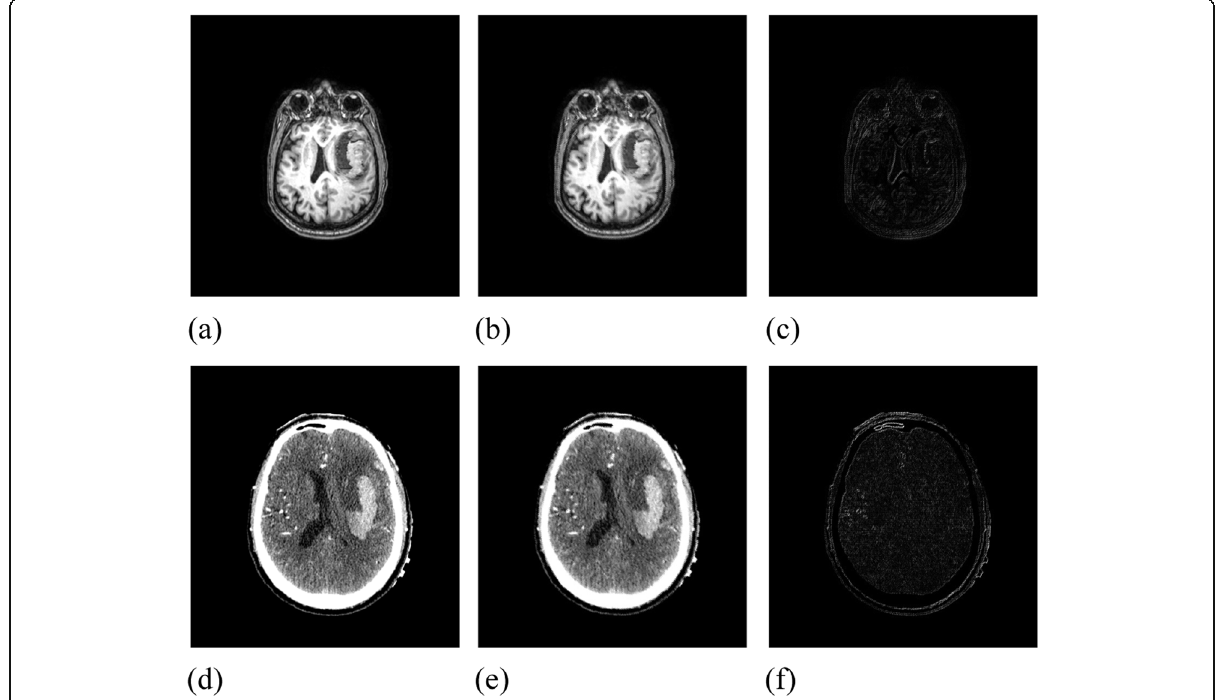
Fig. 7 Initial image data. ( a ): MRI reference image; ( b ): MRI moving image; ( c ): Difference between MRI reference image and moving image; ( d ): CT reference image; ( e ): CT moving image; ( f ): Difference between CT reference image and moving image